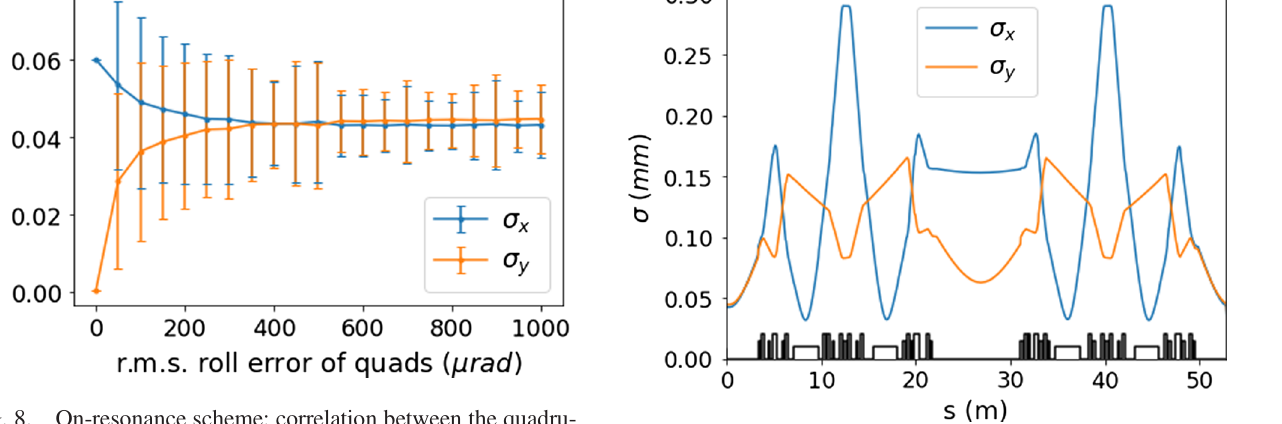
FIG. 10. On-resonance scheme: horizontal and vertical beam sizes of one supercell for one specific random seed with 500 μ rad quadrupole roll errors. Such data can be used for the beam lifetime estimation.